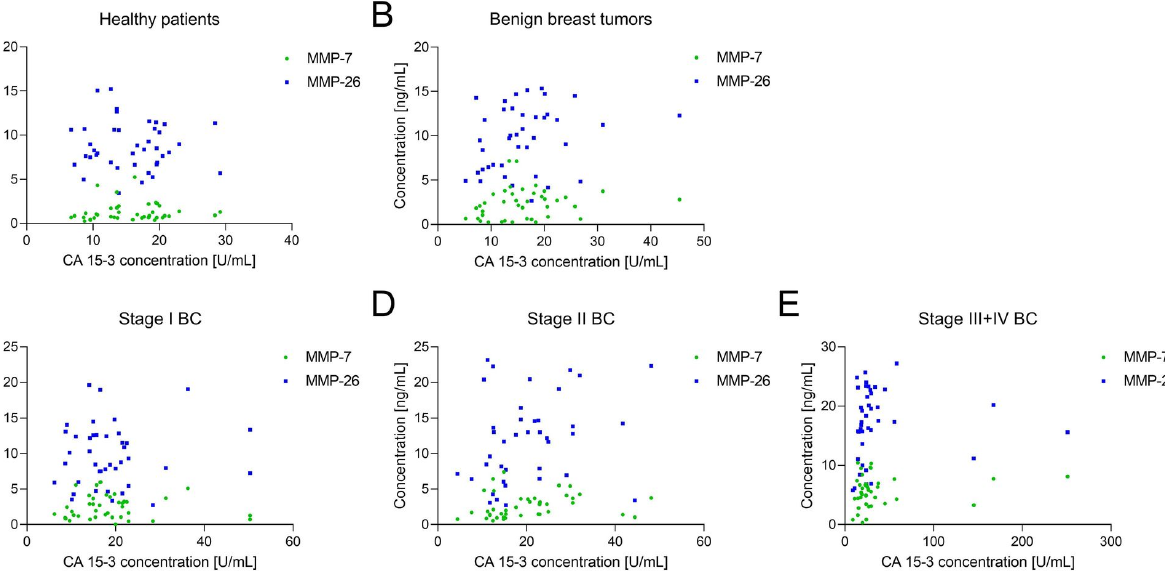
Figure 2. Scatterplots for plasma levels of MMP-7 and MMP-26 from CA 15-3 in healthy ( A ), benign breast tumour ( B ) and BC patients: Stage I ( C ), Stage II ( D ), Stage III + IV ( E ). BC, breast cancer; CA 15-3, cancer antigen 15-3; MMP-7, matrix metalloproteinase 7; MMP-26, matrix metalloproteinase 26.